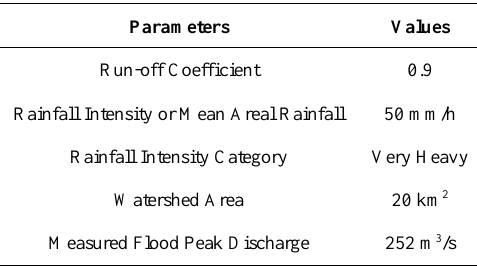
Table 3. Field-scale Test